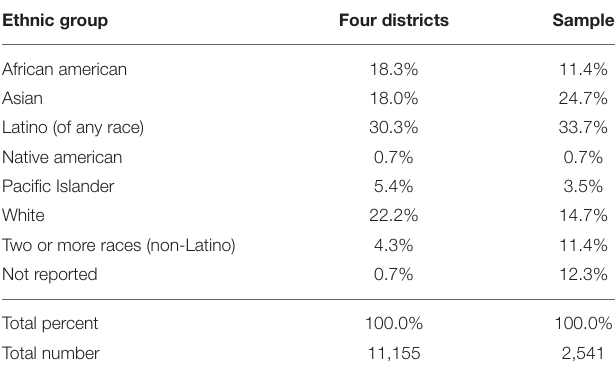
TABLE 1 | Racial/ethnic breakdown of 10th grade population vs.